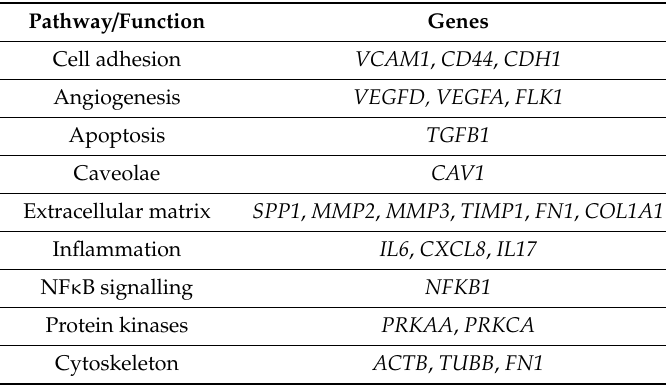
Table 2. Genes involved in spheroid formation